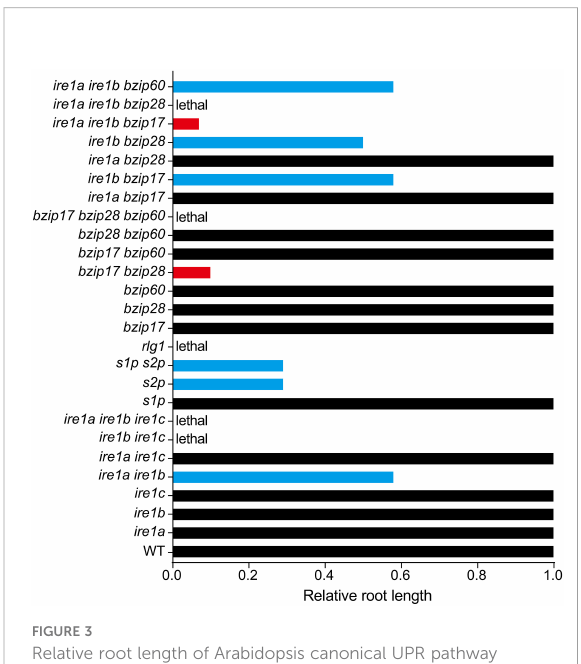
FIGURE 3 Relative root length of Arabidopsis canonical UPR pathway mutants. Root length of WT is set as 1.0, and the black columns indicate the root growth of relevant UPR mutants are not signi fi cantly affected. The blue columns represent about 50% reduction of root length in the relevant mutants. The red columns show stunted root length in two triple knock-out mutants 17ab ( ire1a ire1b bzip17 , ~5% of WT) and bzip17 bzip28 ( bz1728 , ~10% of WT). Data shown in this fi gure are based on published results regarding the root length of relevant UPR mutants compared with their corresponding